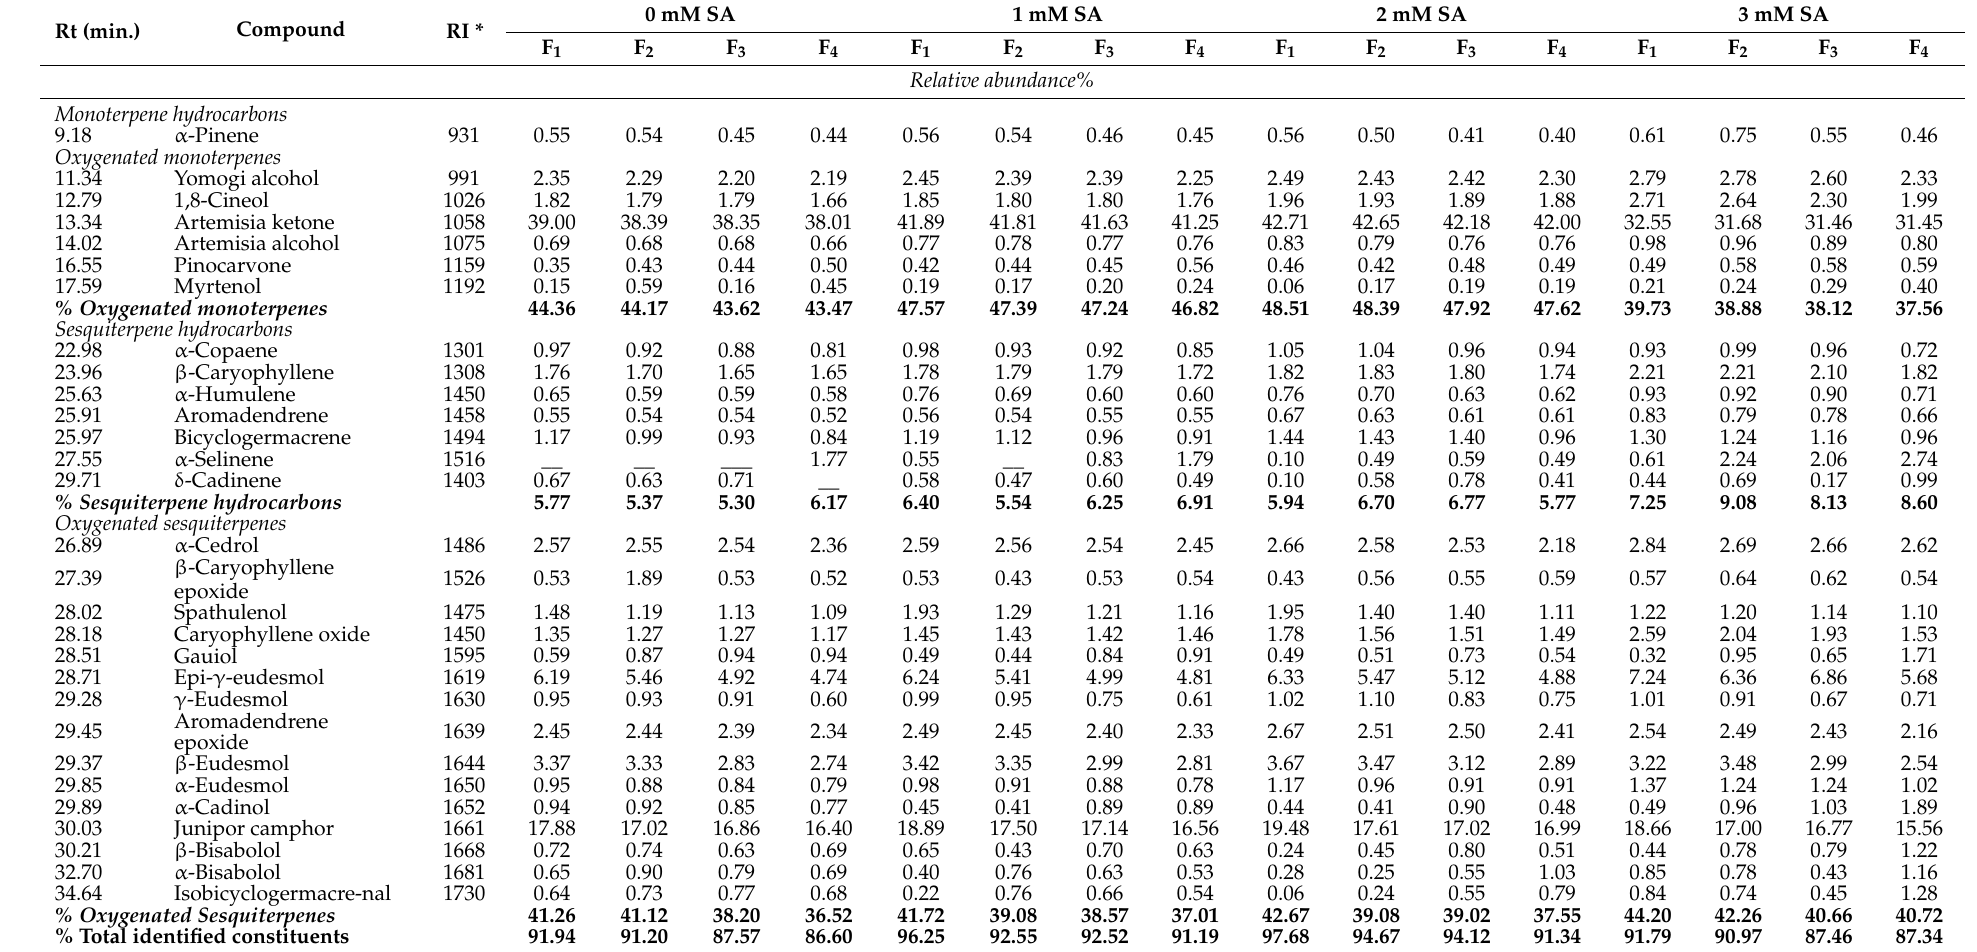
Table 3. Effects of drought stress and foliar spraying of salicylic acid (SA) on the chemical composition of the essential oils of the aerial parts of E. africanus